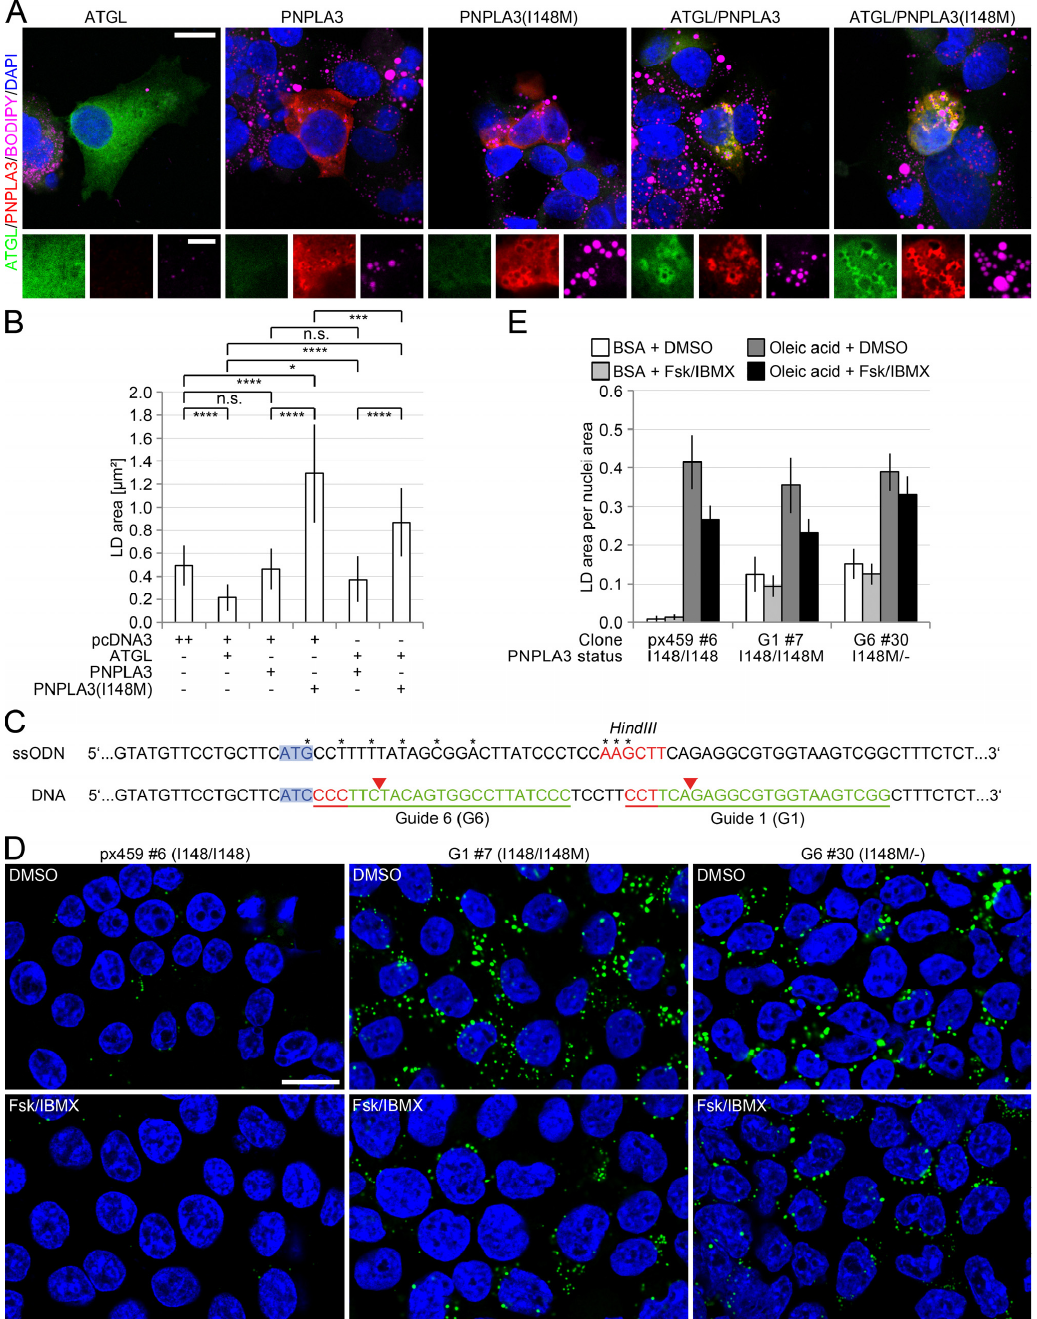
Figure 5. PNPLA3(I148M) negatively regulates ATGL-activity. ( A ) Immunofluorescence analysis of ATGL and PNPLA3 in HepG2 cells transfected with empty vector (n = 25), ATGL (n = 23), PNPLA3 (n = 12), and PNPLA3(I148M) (n = 16) alone or with ATGL in combination with either PNPLA3 (n = 14) or PNPLA3(I148M) (n = 17). Transfection of ATGL (green) led to a complete loss of LDs (LDs: BODIPY, violet; nuclei: DAPI, blue), whereas transfection of PNPLA3 (red) did not significantly